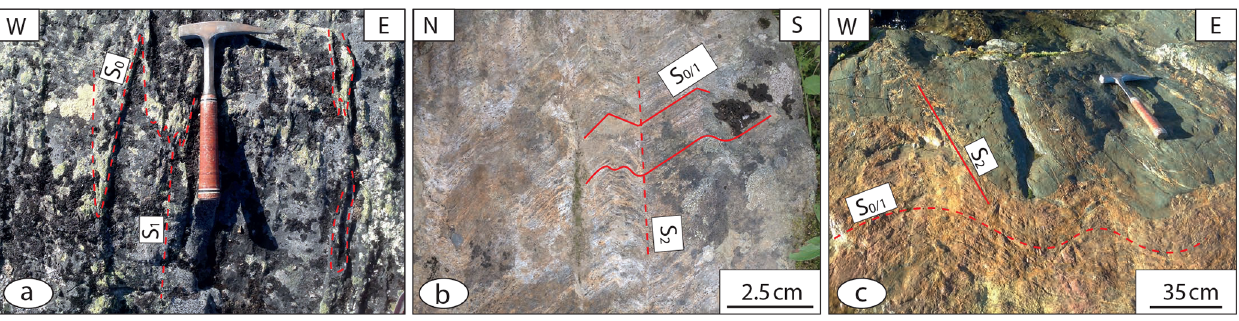
Figure 11. Field images of key localities in the Tjårrojåkka key area. (a) Isoclinal F 1 folding, X675916 Y7515915. (b) Open chevron- style F 2 folding with spaced S 2 , X676285 Y7516107. (c) Open concentric F 2 folding with spaced S 2 , X675985 Y7516176. Coordinates: